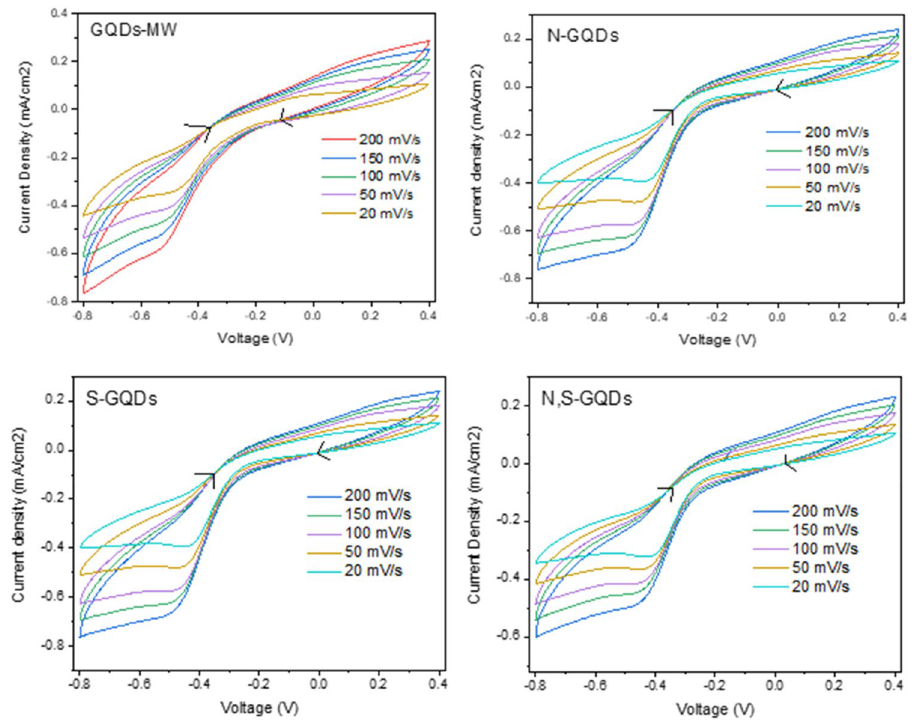
Figure7. Scan Rate dependent CVs of the GQDs in O 2 saturated 0.1 M KOH. Scan rates were changed from 200 to 20 mV/s, taken from − 0.8 to 0.4